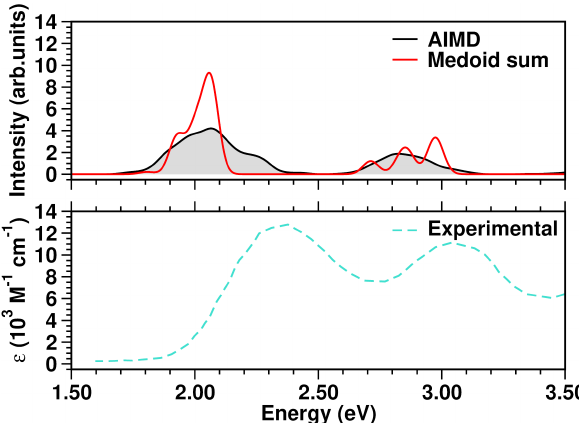
Figure 6. Top panel: comparison of TCNE: π :1ClN simulated absorption spectra in the 1.50–3.50 eV range. Bottom panel: experimental UV-Vis spectrum, retrieved from Ref. [93], of the TCNE: π :1ClN complex measured in DCM solution (molar absorptivity, ε ). The color code is presented in the graph